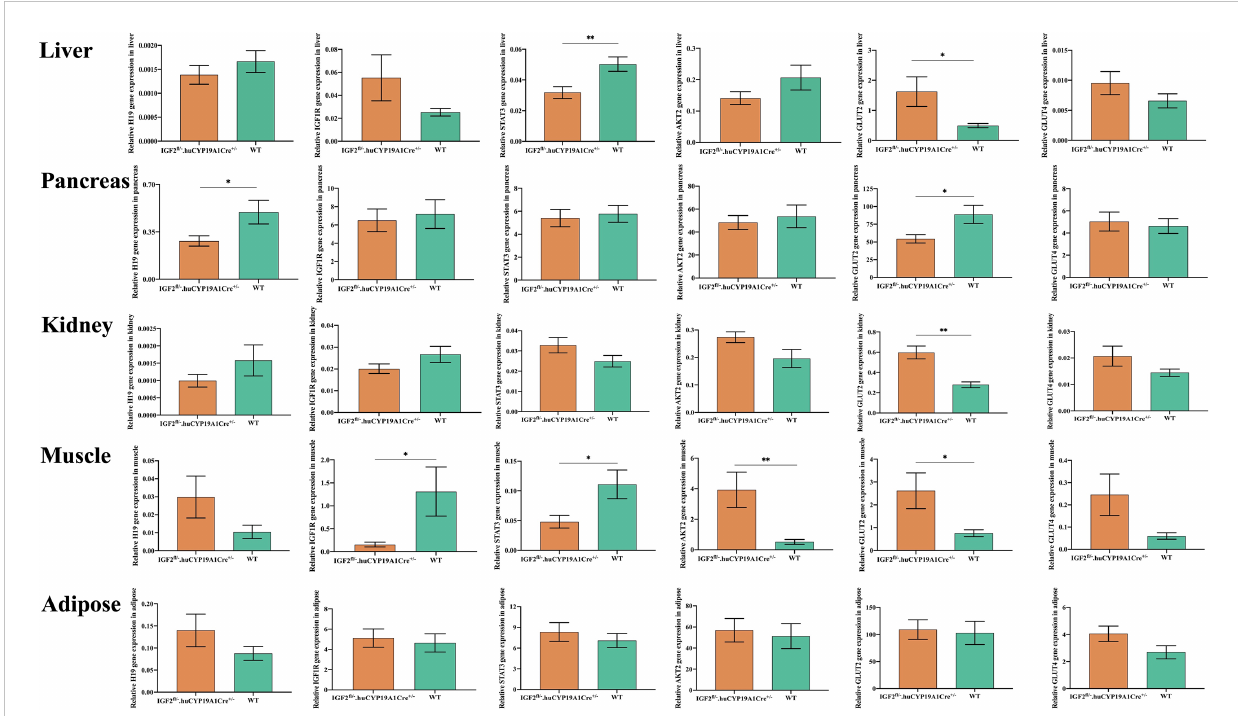
FIGURE 4 Effects of IGF2 overexpression on the genes of the pathway related to glycolipid metabolism in adult mouse tissues; n=4-6 mice in each group. * P < 0.05; ** P < 0.01.